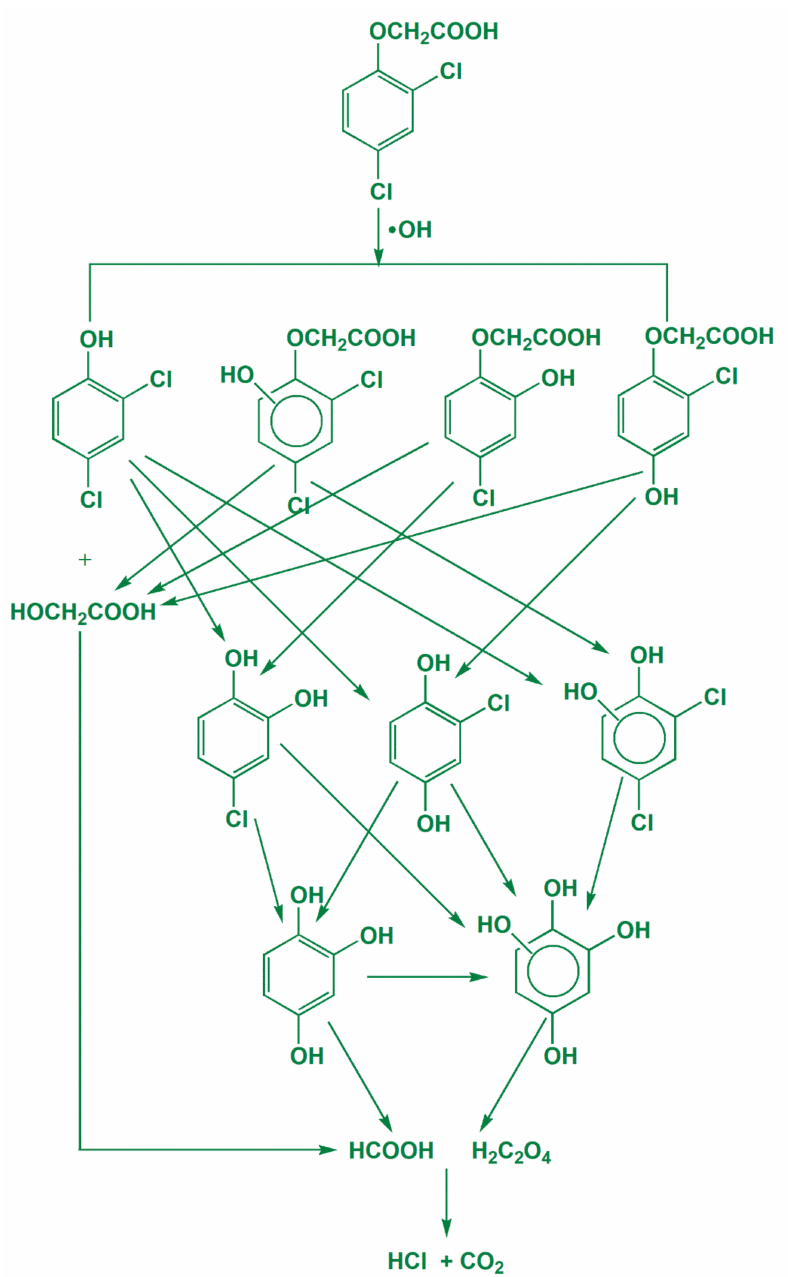
Scheme 7. Proposed decomposition pathway for 2,4-D decomposition in